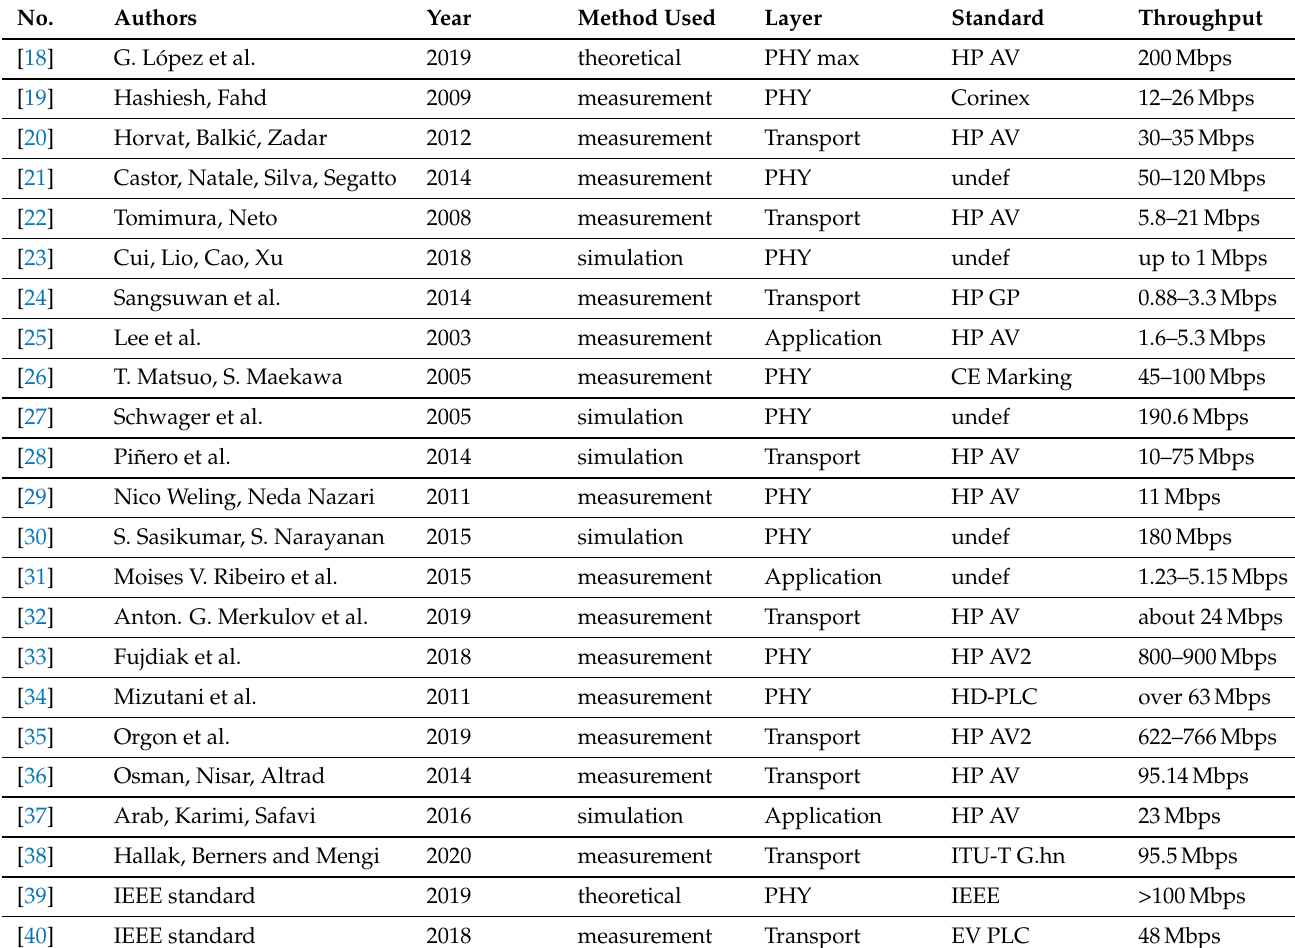
Table 1. Summary of related